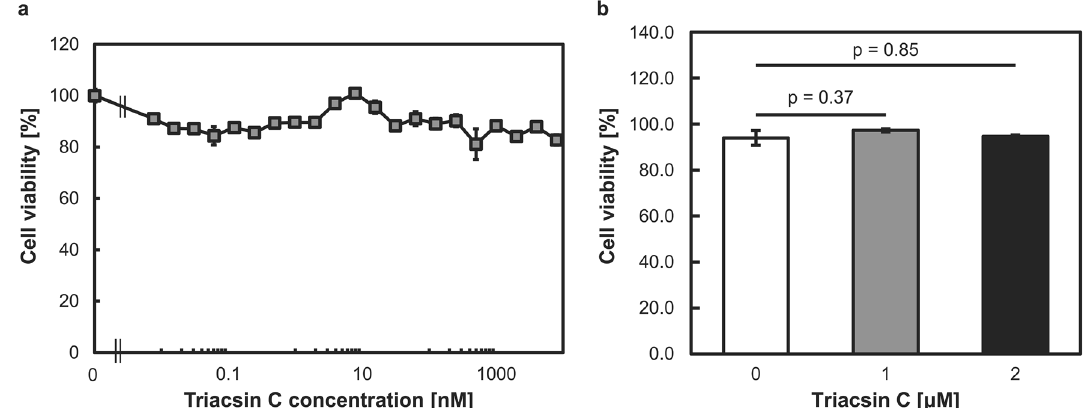
Figure 3. Effects of triacsin C on PC-3 cell proliferation. Cells were treated with various concentrations of triacsin C for 72 h. ( a ) Cell viability was determined using the MTT assay. n = 4. ( b ) Cell viability was determined using the trypan blue stain. n = 3. Bars represent the SE.